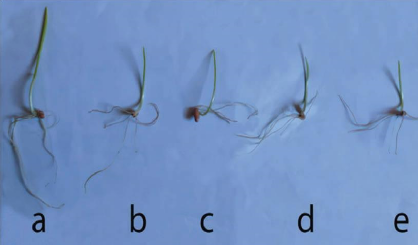
Figure 6: Efect of AgNPs on wheat growth and development after 10 days: (a) control, (b–e) exposure to AgNPs (25, 50, 75, and 100 μ g · L − 1 ).